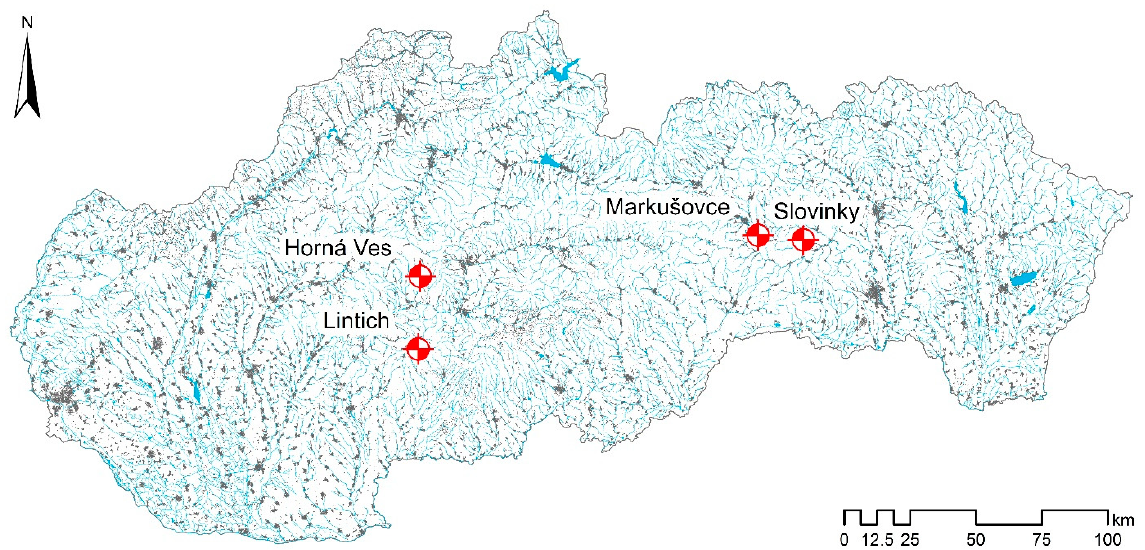
Figure 1. Location of sampling areas in the map of Slovakia: Slovinky (SLS-slag, SLD-dam), Markušovce (MAS-sludge, MAD-dam), Lintich (LIS-sludge, LID-dam), Horná Ves (HVS-sludge, HVD-dam).